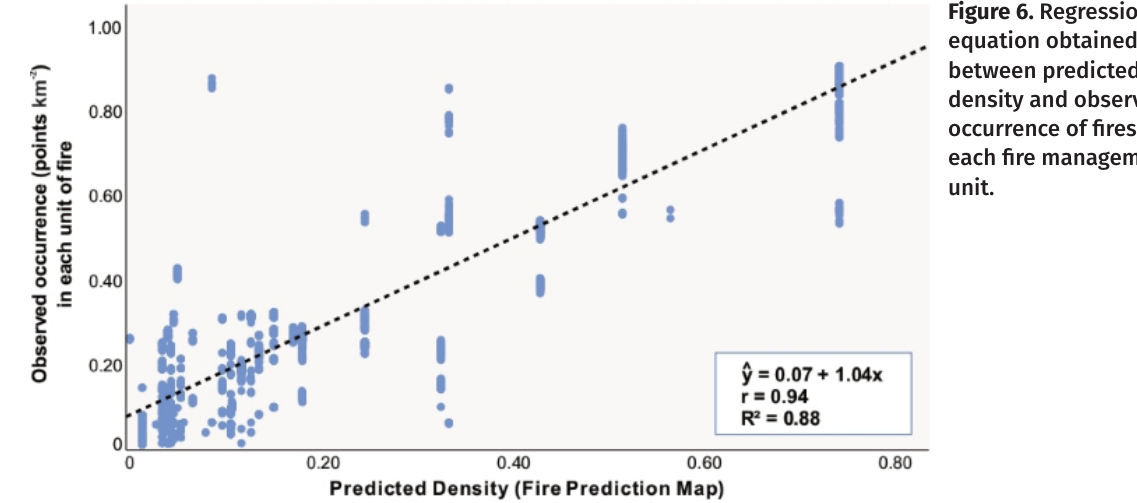
Figure 6. Regression equation obtained between predicted density and observed occurrence of fires in each fire management